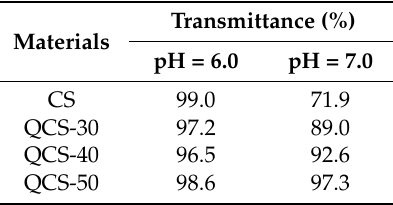
Table 2. The pH dependence of water solubility of CS and